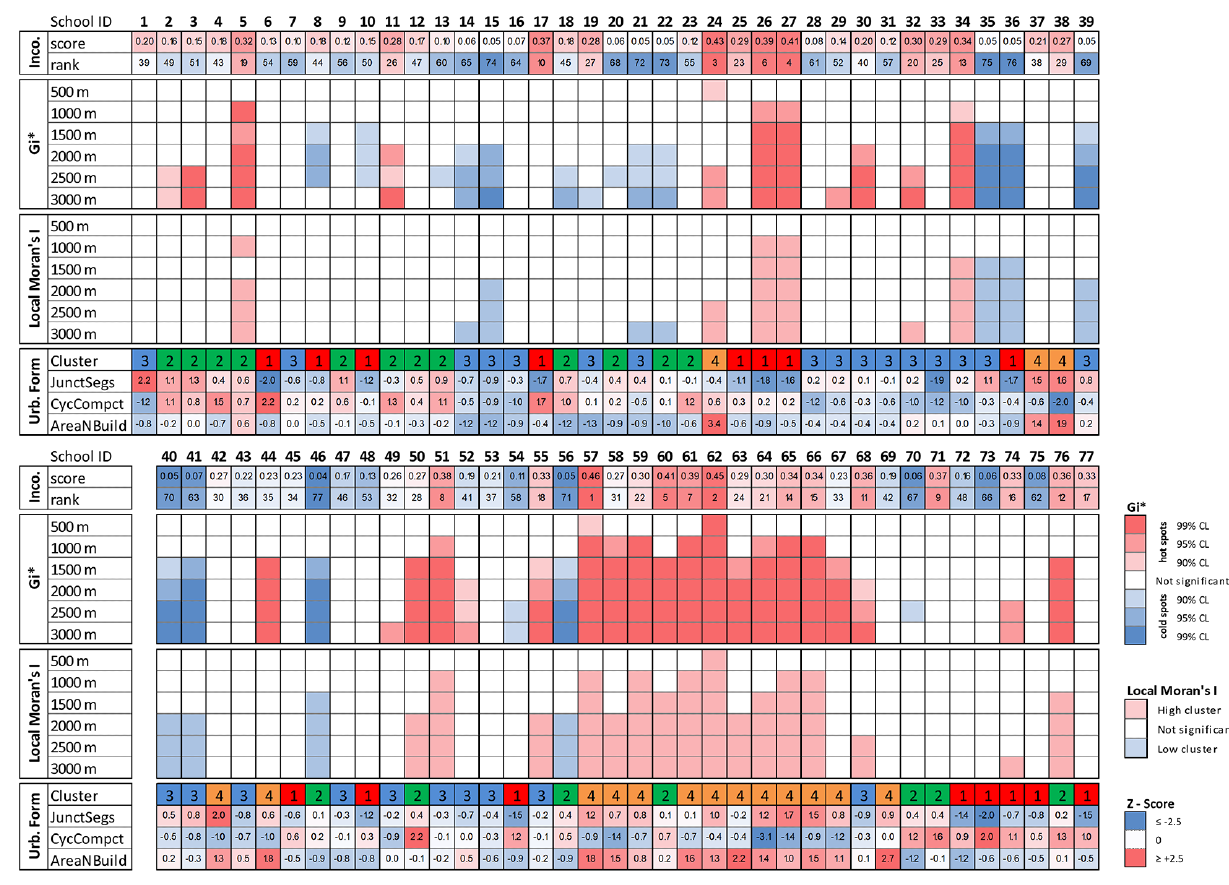
Figure 10. Social and physical contexts of the 77 secondary